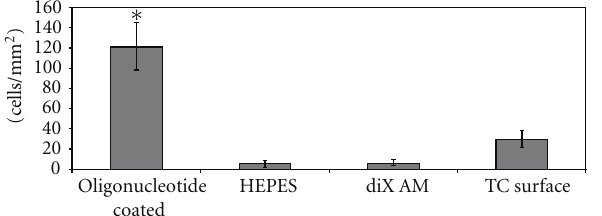
Figure 6: Adhesion of HUVECs to oligonucleotide-coated diX AM surfaces in FCS containing-medium under dynamic conditions compared to tissue culture (TC) surfaces. Samples were incubated with 0,05 ∗ 10 6 cells for 1 h in medium containing FCS. Number of adhered cells per mm 2 was counted in microscopy images ( n = 9). Group marked with ∗ is significantly di ff erent to HEPES, diX AM, and TC surface samples ( P < 0 . 05).